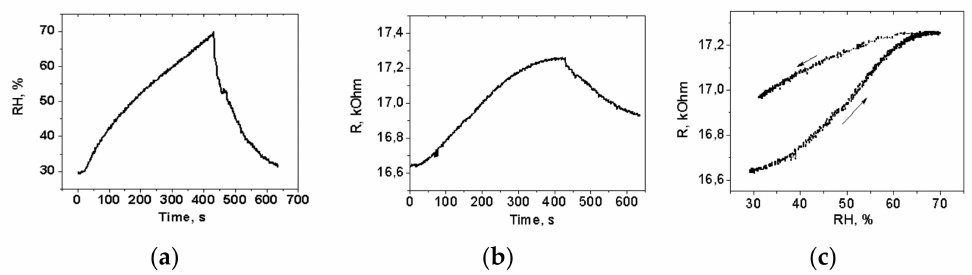
Figure 9. ( a ) Dependence of humidity on time measured by an commercial HIH4000 sensor ( b ) Dependence of electrical resistance on measurement time with increasing and decreasing humidity ( c ) Dependence of the resistance of the humidity sensor for a two-sided humidity